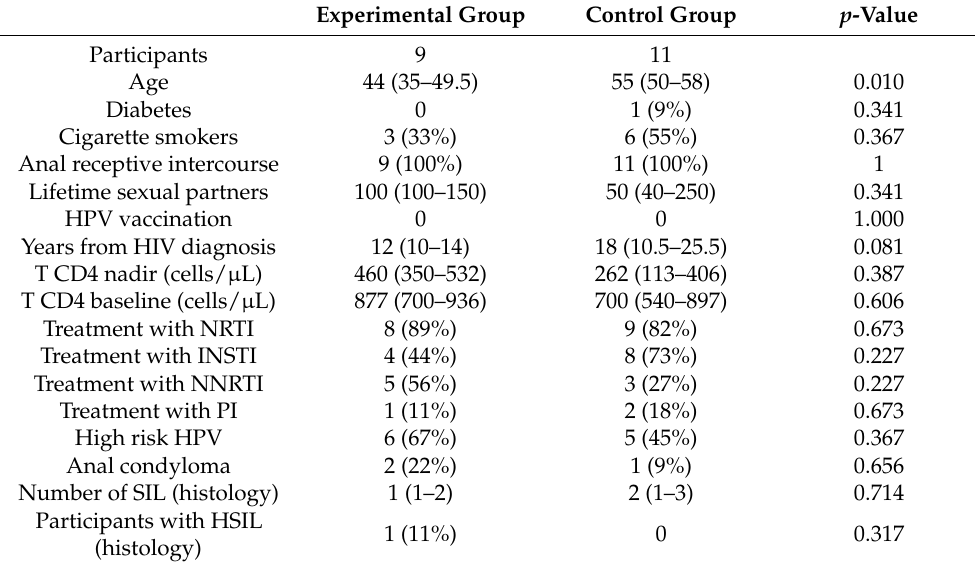
Table 1. Baseline characteristics (T0) of the study population. Data are reported as total number (%) ore median (IQR).